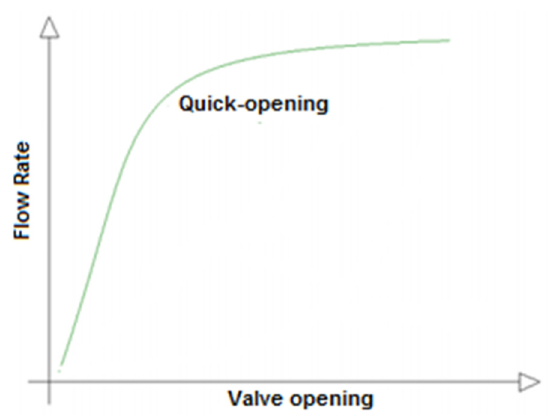
Figure 25. Controllability characteristic curve of a quick-opening valve [35].